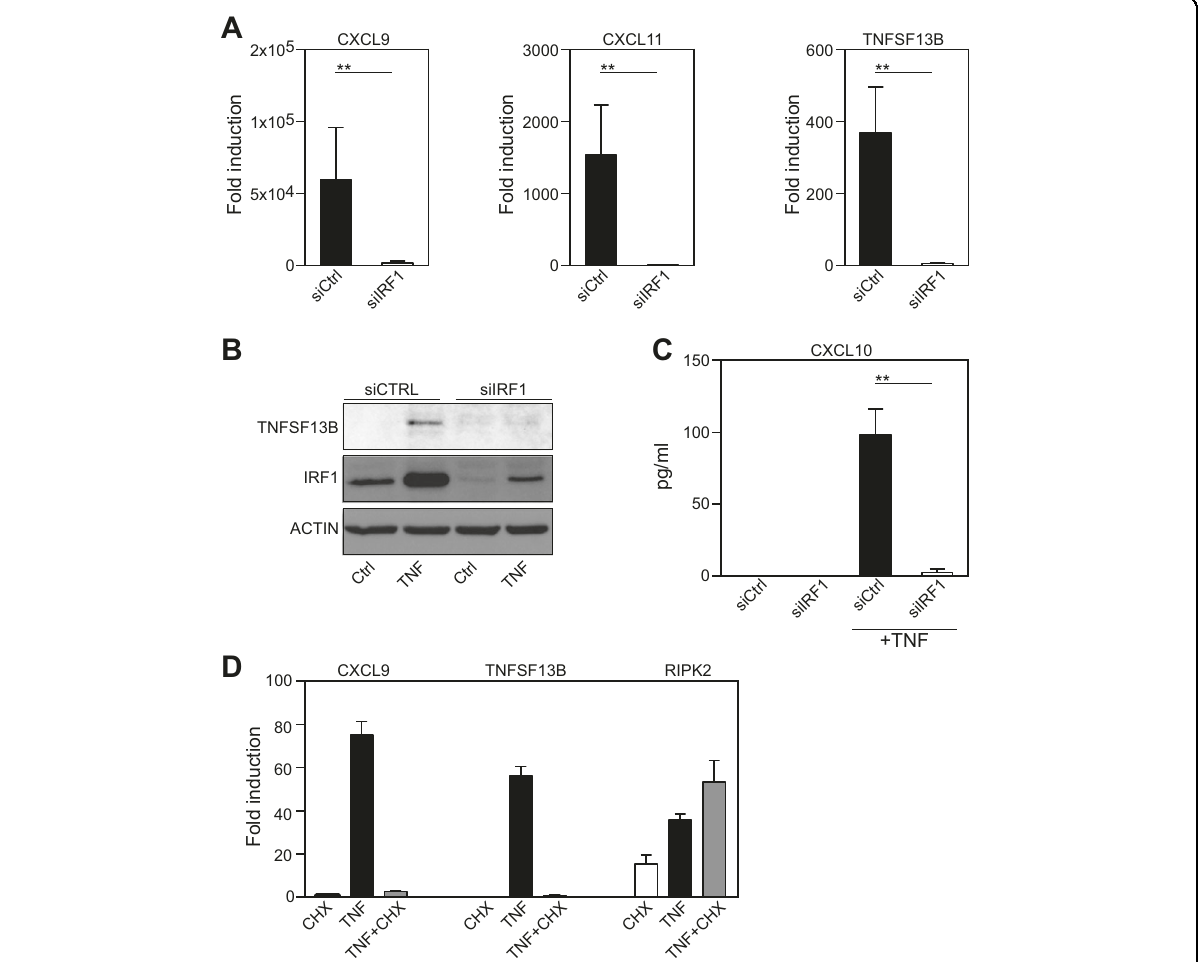
Fig. 3 IRF1 is critical for the TNF-induced expression of CXCR3-binding chemokines and TNFSF13B. a – c FLSs were transfected with nontargeting (siCTRL) or IRF1-targeting siRNA pools. a Transfected FLSs from seven donors with RA were treated with TNF (10 ng/ml) for 6 h. Gene expression was determined by qPCR. Expression in the treated cells is presented relative to that in the unstimulated cells. Values are shown as the mean ± SEM. ** p < 0.01, Wilcoxon matched-pairs test. b RA-FLSs were stimulated with TNF for 24 h. Representative western blots of at least four experiments with different RA-FLS cell lines are shown. c . IRF1 expression knockdown FLSs ( n = 4) were treated with TNF (10 ng/ml) for 24 h. Supernatants were analyzed for CXCL10 expression by ELISA. Values are shown as the mean ± SEM. d qPCR was used to analyze gene expression in human RA-FLSs treated with TNF in the absence or presence of cycloheximide (CHX, 20 μ g/ml). Each experiment was performed in technical triplicates (error bars, SEM of triplicates). Expression in the treated cells is presented relative to that in the unstimulated